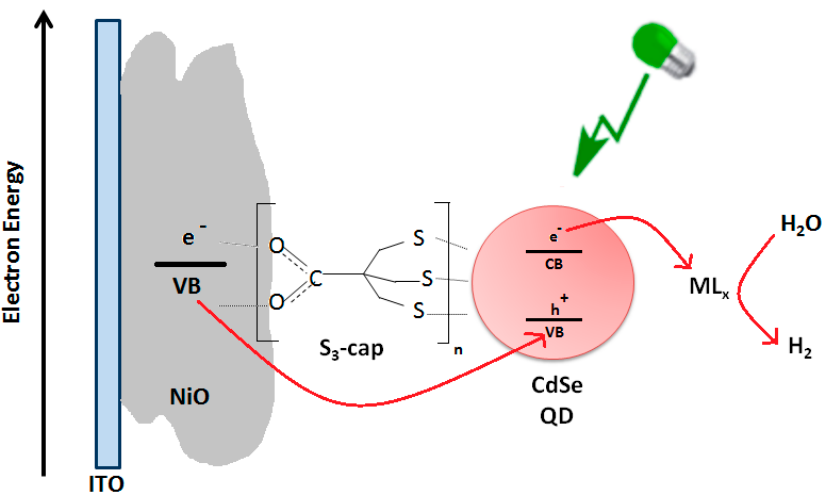
Figure 14. Scheme of the photoelectrochemical evolution of H 2 using S 3 ‐ cap ‐ CdSe QD ‐ sensitized NiO as photocathode. The complex ML x indicates the catalyst forming molecular hydrogen [Co(1,2 ‐ benzenedithiolate) 2 ] − . Adapted from reference [72].